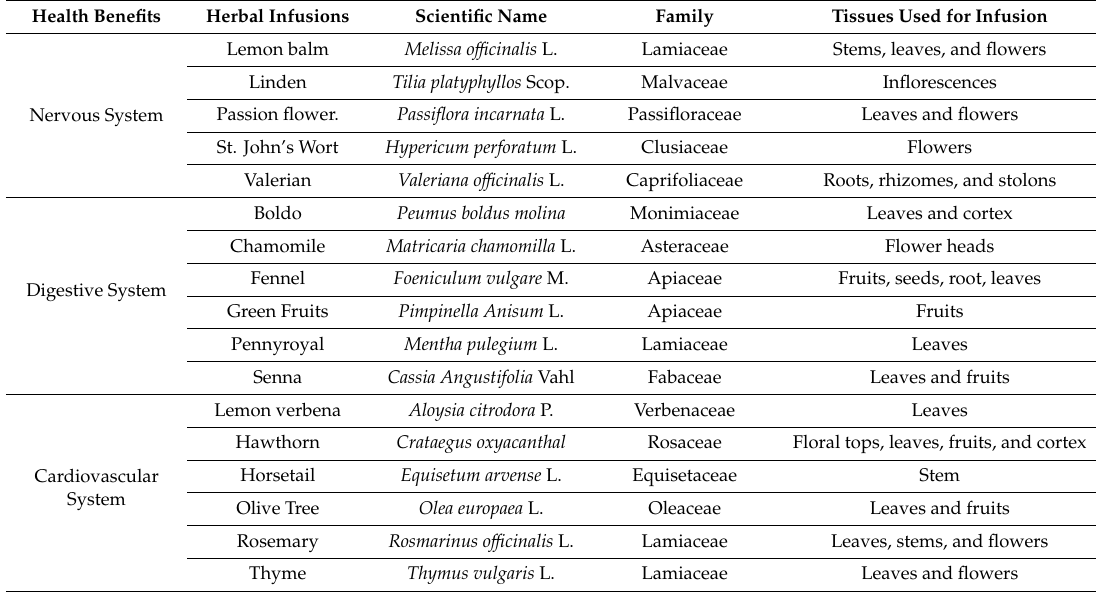
Table 1. Botanical names, families, medicinally used parts, and health benefits of various aromatic and medicinal plants. Adapted from Herrera et al.